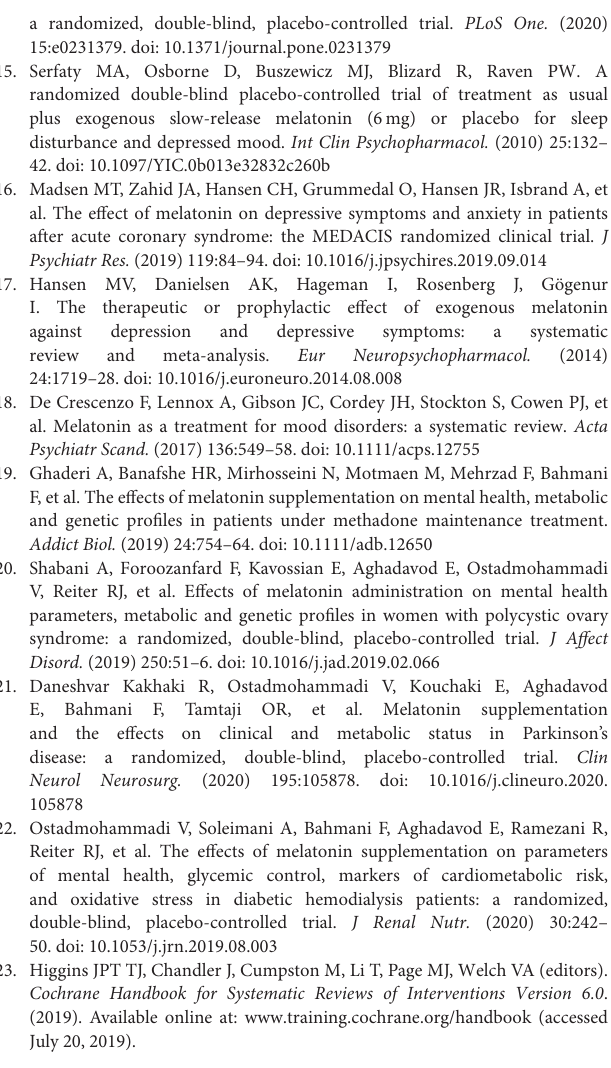
Supplementary Figure S8 | Meta-analysis on GDS score. GDS, Yesavage Geriatric Depression Scale; SMD, standardized mean difference; CI, confidence interval. Supplementary Figure S9 | Funnel plot analysis on BDI score. SMD, standardized mean difference; SE, standard error. Supplementary Figure S10 | Funnel plot analysis on HADS-D score. SMD, standardized mean difference; SE, standard error. Supplementary Figure S11 | Sensitivity analysis on all scales. Supplementary Figure S12 | Sensitivity analysis on BDI score. Supplementary Figure S13 | Sensitivity analysis on HADS-D score. Supplementary Figure S14 | Adverse event analysis. OR, Odds Ratio; CI, confidence interval. Supplementary Table S1 | Checklist of the Preferred Reporting Items for Systematic Reviews and Meta-Analyses (PRISMA). Y, the item was reported in article; N, the item was not reported. Supplementary Box 1 | Study